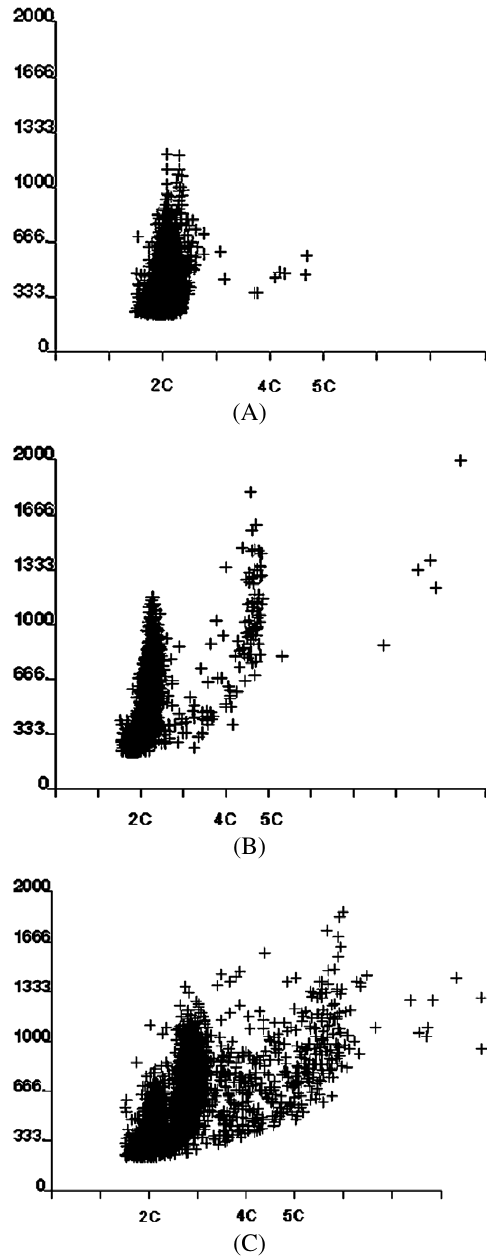
Fig. 2. DNA amount vs. nuclear size scattergrams. Cervical cell nu- clei were stained by Thionin–Feulgen stain. The horizontal bar on the y-axis indicates the nuclear area in number of pixel (one pixel representing approximately 0.1 µ m 2 area). (A) Histogram of the DNA amount distribution of normal cervical cells without any 5c cells (DNA index, DI 2 . 5 = 5c). (B) Histogram of the DNA amount distribution of a CIN3 case with a few cells having DNA amount greater then 5c. (C) DNA histogram of a case of invasive cervical cancer with aneuploid stem cells and a large number of cells with DAN amount greater than